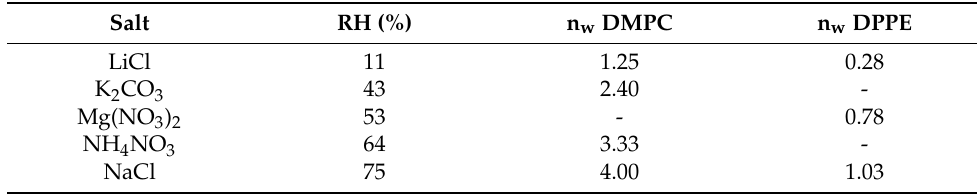
Table 1. Saturated salt solutions and corresponding relative humidity at 25 ◦ C exploited for the sample preparation, along with the respective number of water molecules per